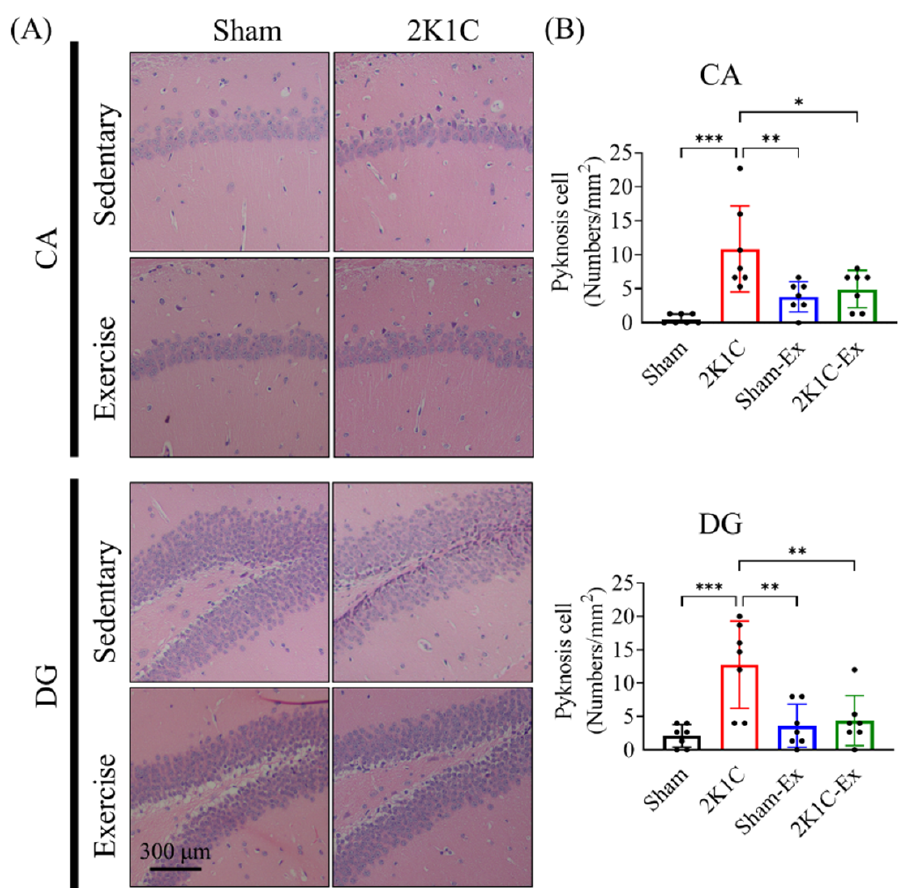
Figure 3. Exercise prevents the 2K1C-hypertension-induced hippocampus neuronal cell pyknosis. ( A ) The H&E staining micrographs for CA1 (CA) and dentate gyrus (DG) of hippocampal. ( B ) The quantitative result for pyknosis cell density in the CA and DG. The averaged data and s.d. are plotted. The statistical analysis was performed by one-way ANOVA and Holm-Sidak’s multiple comparisons. The sample sizes are seven for each group. *: p < 0.05 **: p < 0.01, ***: p < 0.001. Scale bar, 300 μ m.